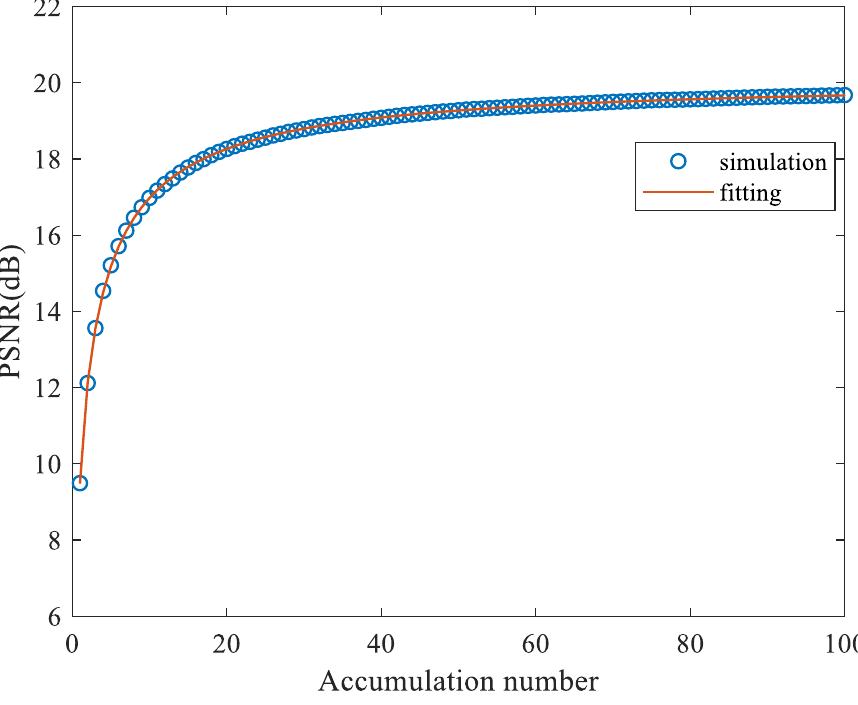
Figure 5. PSNR of the reconstructed image by MIFA binary CGHs (iteration number is 10) as a function of accumulation number. The values of the parameters ( S , K ) of the fitting curve are (3.27, 9.55).